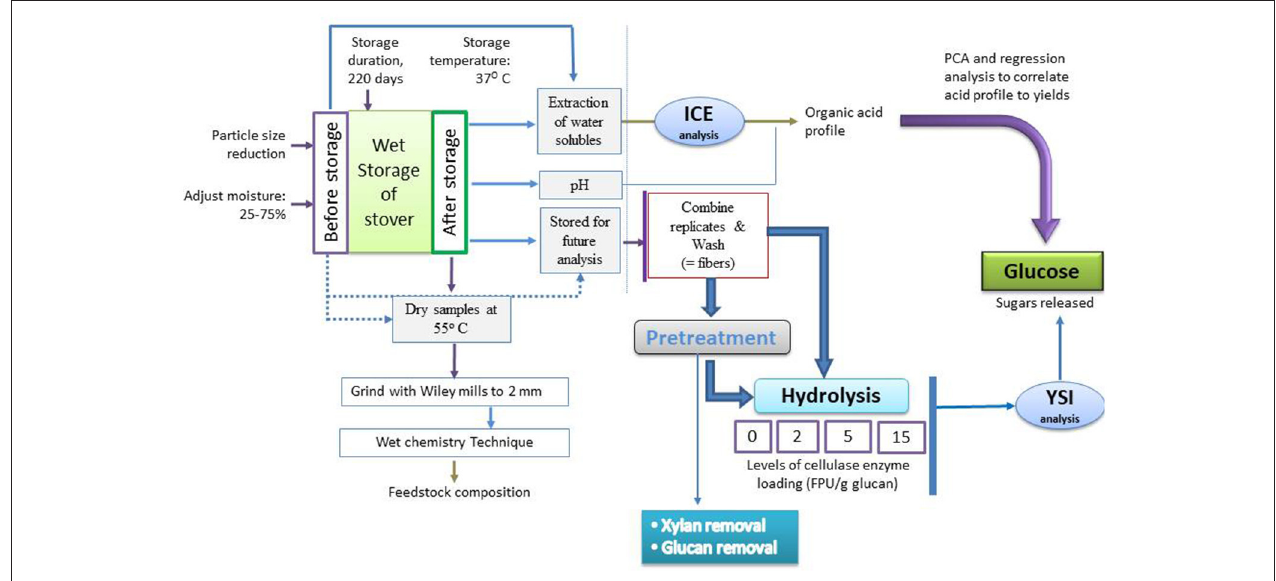
FIGURE 1 | Process flow chart of fiber reactivity—organic acid correlation study; for each process, experiments were performed in triplicate.